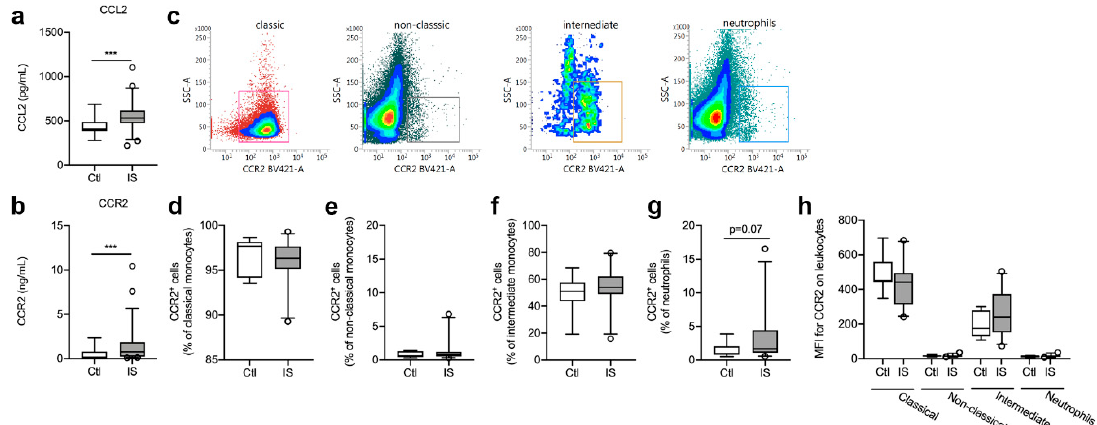
Figure 2. Characterization of CCR2 cell populations in ischemic stroke (IS) patients. ( a ) Electrochemiluminescence analysis of CCL2 plasma concentrations in IS patients ( n = 58) and healthy controls (Ctl, n = 16), demonstrating significantly increased CCL2 plasma levels in IS patients compared to healthy Ctl. ( b ) ELISA analysis of CCR2 plasma concentrations in IS patients ( n = 58) and healthy Ctl ( n = 16), demonstrating significantly increased CCR2 plasma levels in IS patients compared to healthy Ctl. ( c ) Flow cytometry analysis of CCR2 expression on classical monocytes (red gate), non-classical monocytes (black gate), intermediate monocytes (orange gate), and neutrophils (blue gate) in IS. ( d – g ) Quantification of the percentage of CCR2 + classical monocytes ( d ), CCR2 + non-classical monocytes ( e ), CCR2 + intermediate monocytes ( f ), and CCR2 + neutrophils ( g ) in IS compared to healthy Ctl. ( h ) Mean fluorescence intensity (MFI) of CCR2 on classical, non-classical, and intermediate monocytes and on neutrophils in IS ( n = 23) and healthy Ctl ( n = 8). Line: median. Box: 25–75% interquartile range. Whiskers: 5–95% percentile. *** p < 0.001.